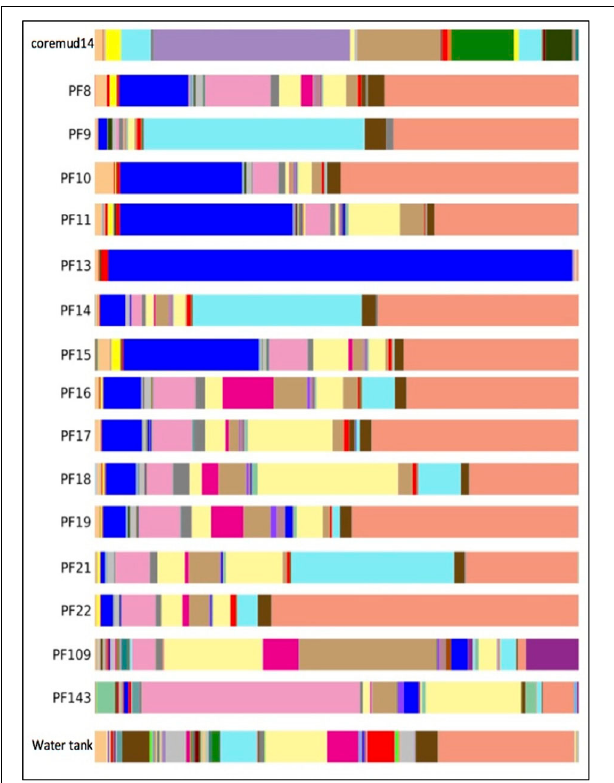
FIGURE 4 | Taxonomic summary of the Paaratte Formation at the genus level. Taxonomic data from the Ribosomal Database Project were used to classify each representative sequence from drilling mud (coremud14), a subset of pre-scCO 2 and post-scCO 2 injection water samples and a representative aliquot of water from surface storage tanks. The corresponding figure legend is provided in Supplementary Figure 5.